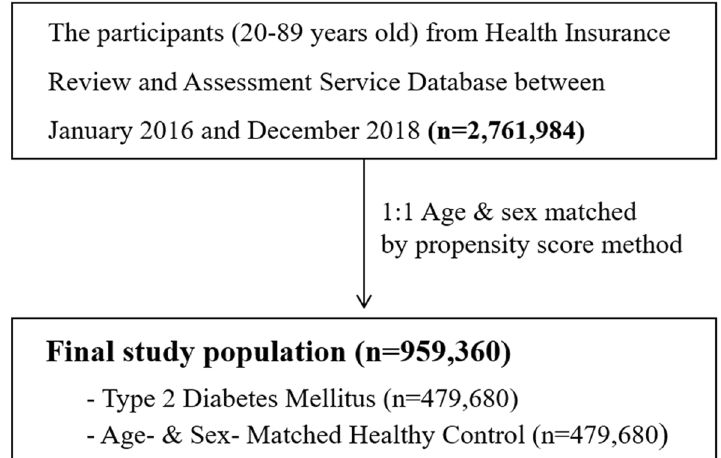
Figure 1. Selection of the study population.